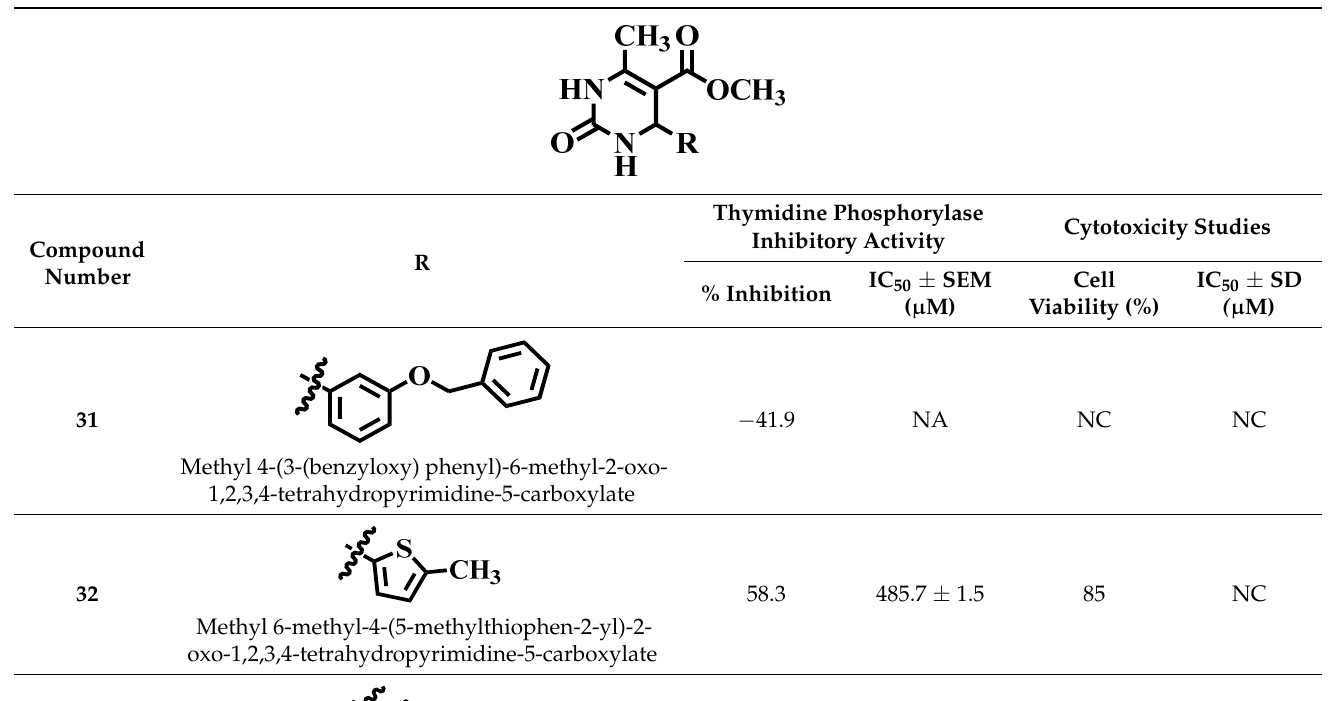
Table 1. Thymidine phosphorylase (TP) inhibitory activity of dihydropyrimidone ( 1 – 40 Table 1. Cont.